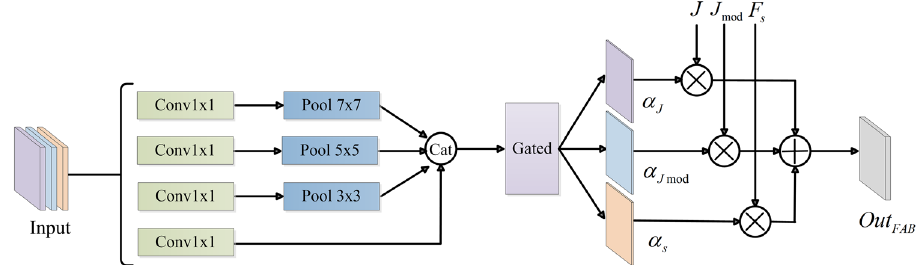
Figure 4. The structure of